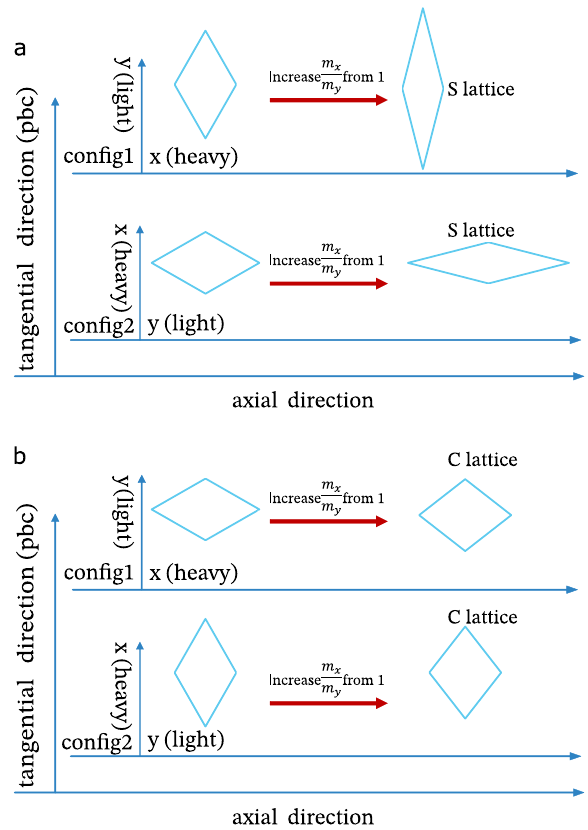
Fig. 6 Mass anisotropy setting and anisotropy induced lattice deformation on cylinder geometry. One can either choose the axial or the tangential direction as the heavy axis, denoted as con fi g1 and con fi g2. In the isotropic limit, the difference between heavy and light axes vanishes; the ground state is a triangular lattice which has two natural ways to be embedded on the cylinder surface. Those serve as two starting points of anisotropy induced deformation for con fi g1 and for con fi g2. The lattice is expected to get compressed along the heavy axis; the two starting points at the isotropic limit lead to two branches of lattice, i.e., the stretched (S) lattice ( a ) and the metastable compressed (C) lattice ( b